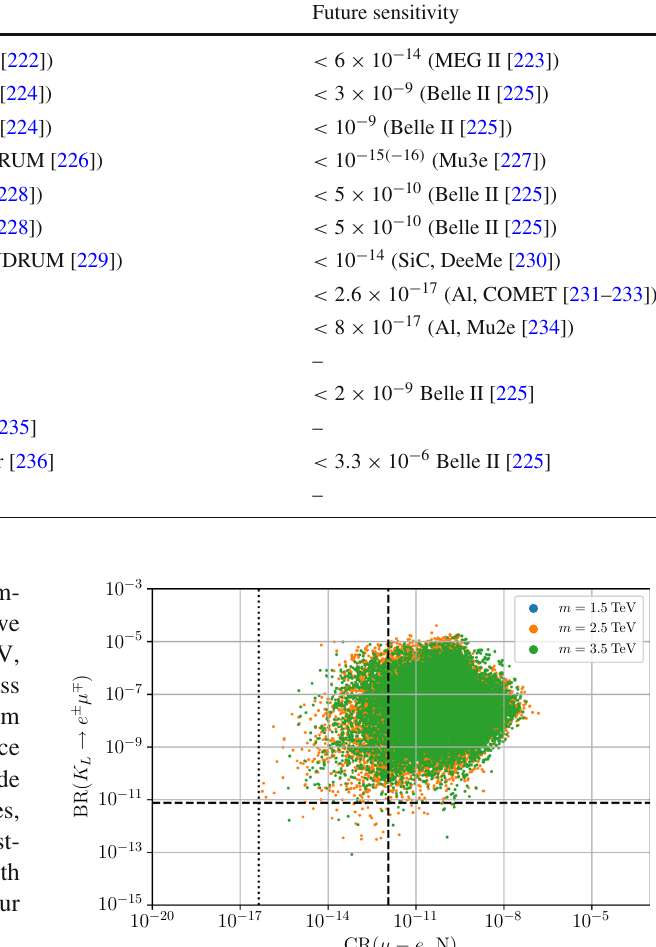
Table 3 Current experimental bounds and future sensitivities of a selection of the most important cLFV observables which constrain the parameter space of V 1 leptoquark models. All upper limits are given at 90% confidence level (CL)